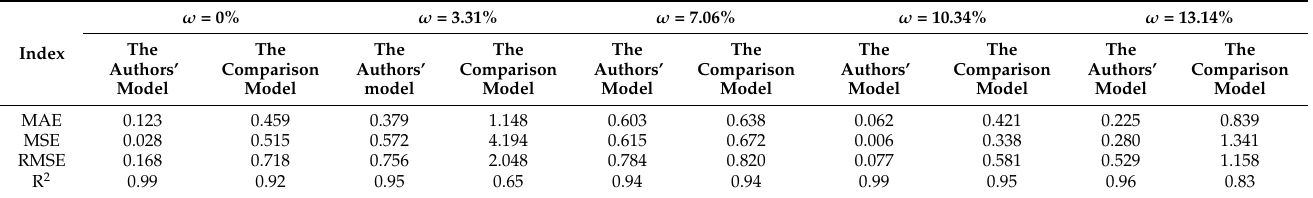
Table 3. The fitting effect evaluation index values of the two models based on the experimental data in test group